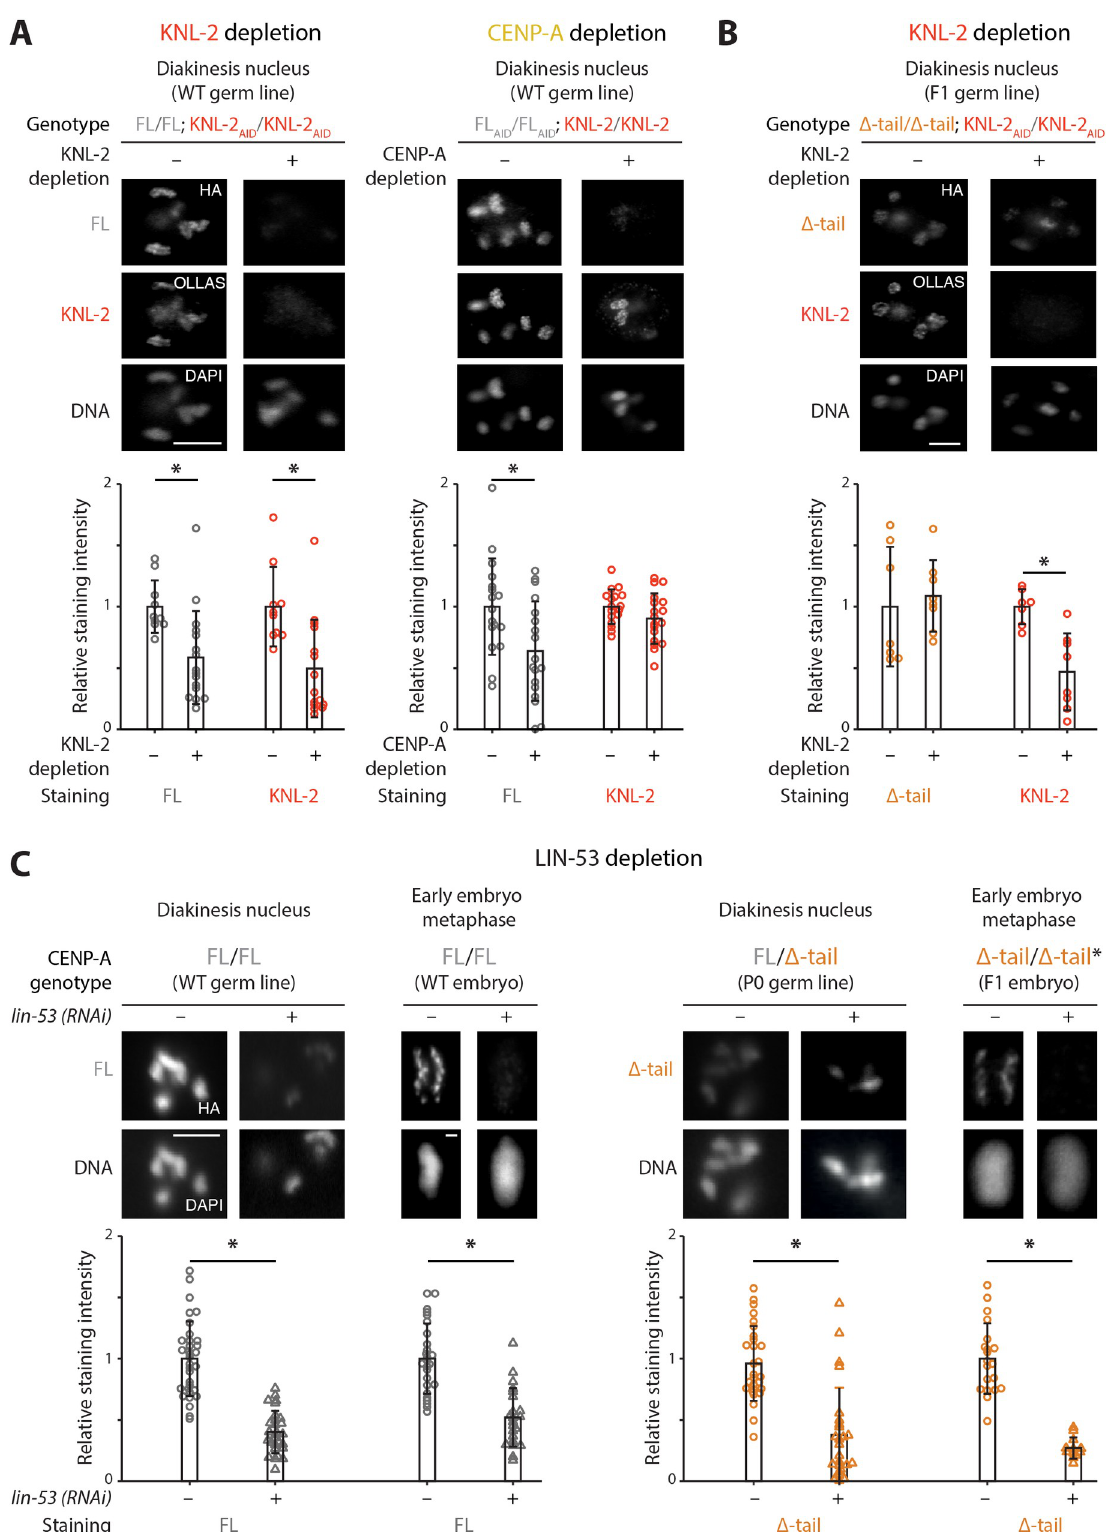
Fig 6. CENP-A Δ -tail is maintained on chromatin by LIN-53 in absence of the interaction with KNL-2. (A) Germline-specific depletion of CENP-A FL and KNL-2 using the AID system. IF images of CENP-A FL and KNL-2 in diakinesis nuclei of